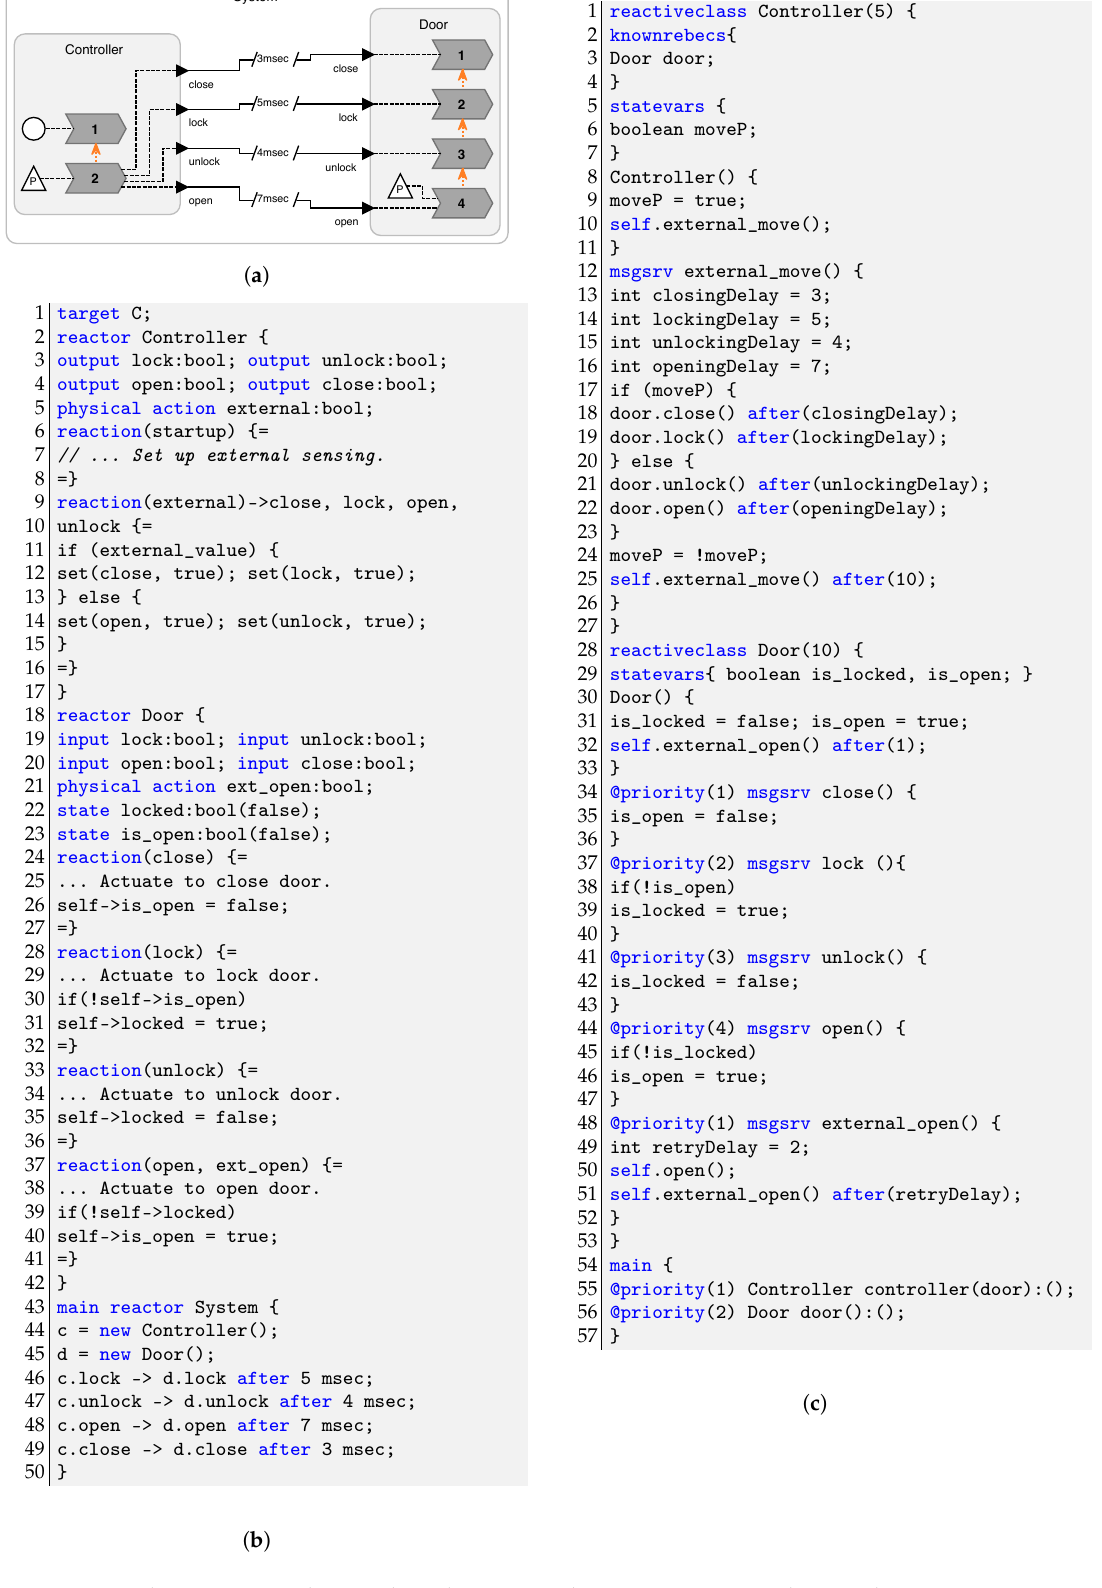
Figure 7. The Door Control Example with an external passenger pressing the open button. Here we added open and close commands for the door and do not show the train. ( a ) Structure of the door controller example. ( b )Variant of Figure 5b with open door. ( c ) The Rebeca model for the code in Figure